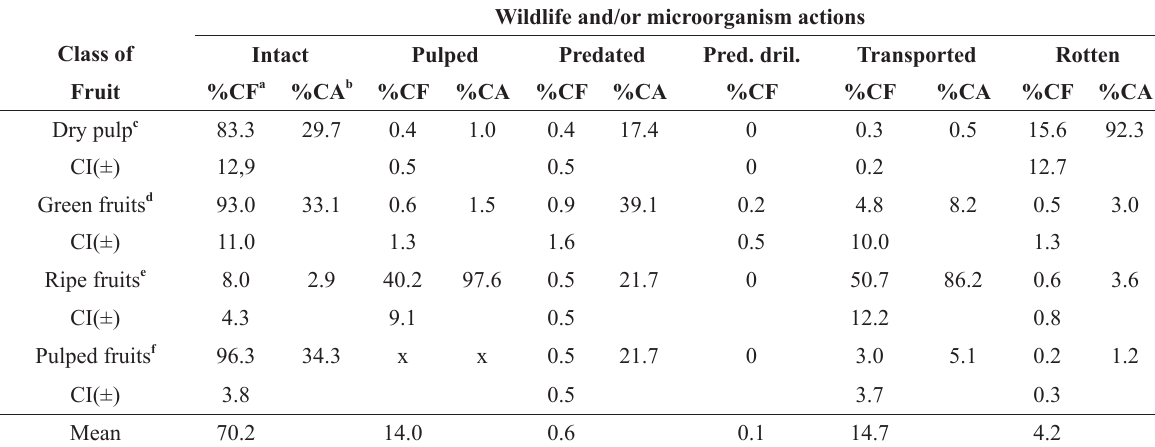
Average percentage of wildlife and microorganismal activity on the different classes of available fruit on the soil during the 2008 and 2009 fruiting seasons. Wildlife and/or microorganism actions Pred. dril. Transported